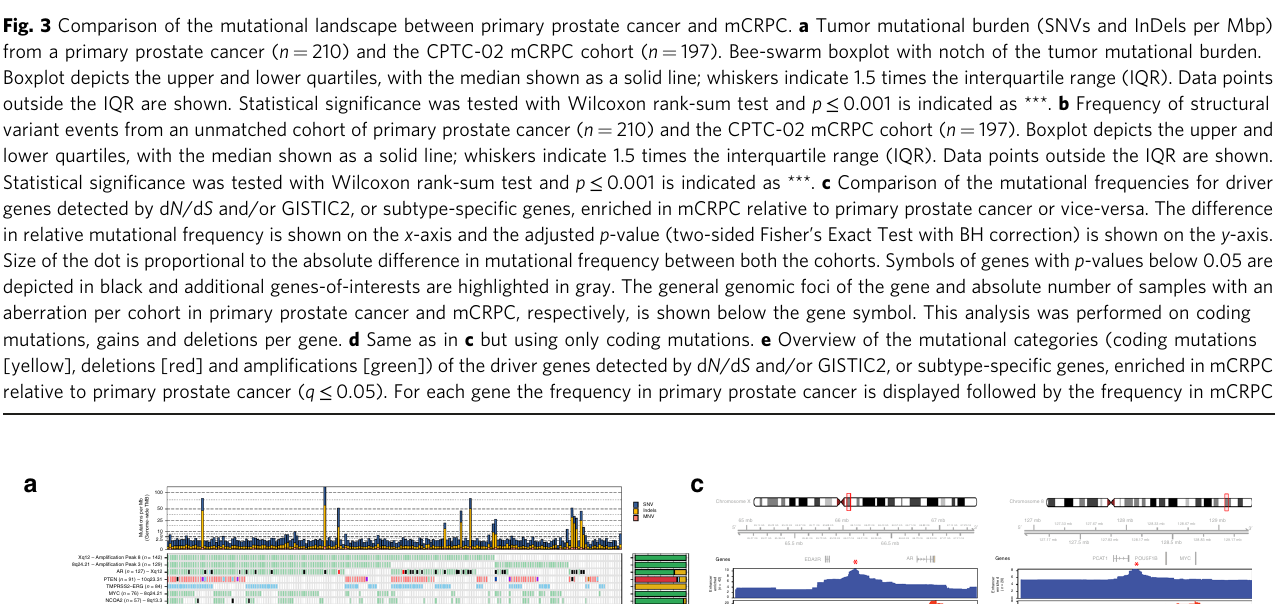
Fig. 3 Comparison of the mutational landscape between primary prostate cancer and mCRPC. a Tumor mutational burden (SNVs and InDels per Mbp) from a primary prostate cancer ( n = 210) and the CPTC-02 mCRPC cohort ( n = 197). Bee-swarm boxplot with notch of the tumor mutational burden. Boxplot depicts the upper and lower quartiles, with the median shown as a solid line; whiskers indicate 1.5 times the interquartile range (IQR). Data points outside the IQR are shown. Statistical signi fi cance was tested with Wilcoxon rank-sum test and p ≤ 0.001 is indicated as ***. b Frequency of structural variant events from an unmatched cohort of primary prostate cancer ( n = 210) and the CPTC-02 mCRPC cohort ( n = 197). Boxplot depicts the upper and lower quartiles, with the median shown as a solid line; whiskers indicate 1.5 times the interquartile range (IQR). Data points outside the IQR are shown. Statistical signi fi cance was tested with Wilcoxon rank-sum test and p ≤ 0.001 is indicated as ***. c Comparison of the mutational frequencies for driver genes detected by d N /d S and/or GISTIC2, or subtype-speci fi c genes, enriched in mCRPC relative to primary prostate cancer or vice-versa. The difference in relative mutational frequency is shown on the x -axis and the adjusted p -value (two-sided Fisher ’ s Exact Test with BH correction) is shown on the y -axis. Size of the dot is proportional to the absolute difference in mutational frequency between both the cohorts. Symbols of genes with p -values below 0.05 are depicted in black and additional genes-of-interests are highlighted in gray. The general genomic foci of the gene and absolute number of samples with an aberration per cohort in primary prostate cancer and mCRPC, respectively, is shown below the gene symbol. This analysis was performed on coding mutations, gains and deletions per gene. d Same as in c but using only coding mutations. e Overview of the mutational categories (coding mutations [yellow], deletions [red] and ampli fi cations [green]) of the driver genes detected by d N /d S and/or GISTIC2, or subtype-speci fi c genes, enriched in mCRPC relative to primary prostate cancer ( q ≤ 0.05). For each gene the frequency in primary prostate cancer is displayed followed by the frequency in mCRPC